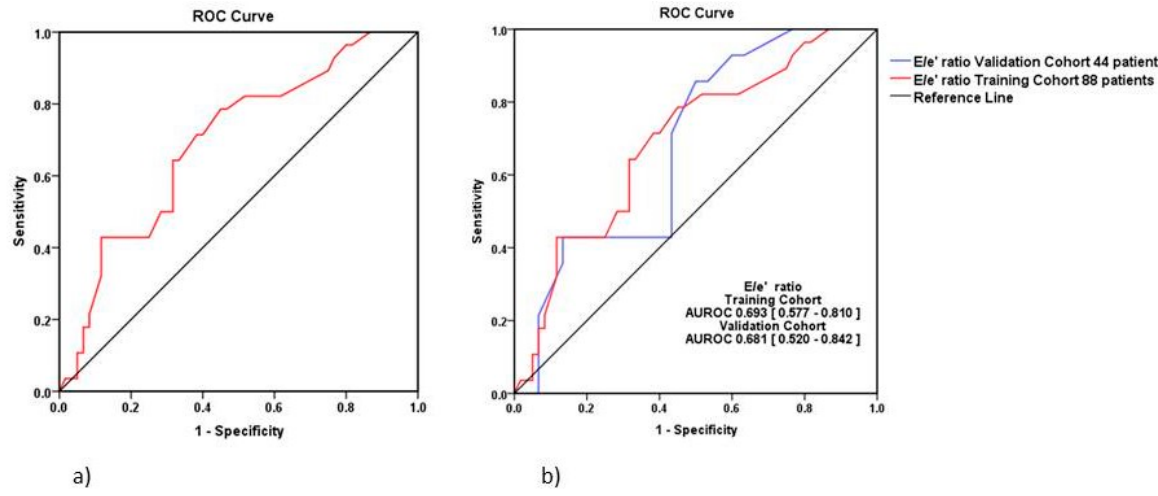
Figure 2. The ROC curve for HFR according to E/e’ ratio (prediction values from the regression equation) at 6 months from the first episode of HFpEF. ( a ) Training cohort (AUROC = 0.693, 95% CI = 0.577–0.810, p = 0.009); ( b ) Comparison between the training cohort (red) and the validation contingent